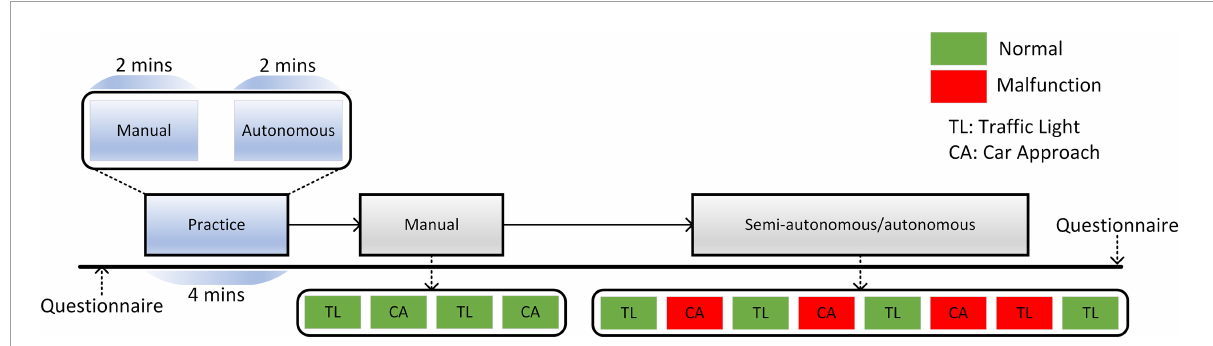
FIGURE1 The experimental protocol of the work.